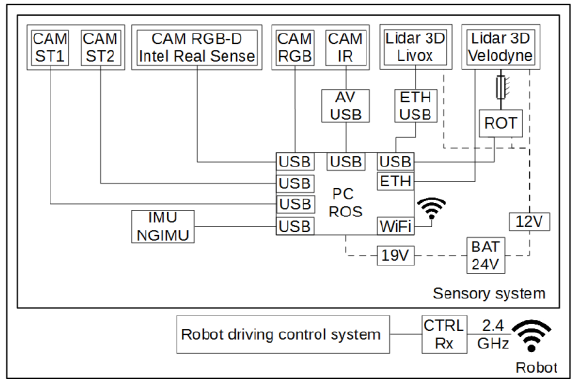
Figure 2: Diagram of connection of the sensory